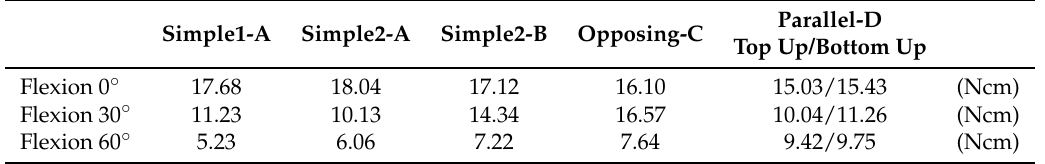
Table 3. Maximum average joint torques for flexion.